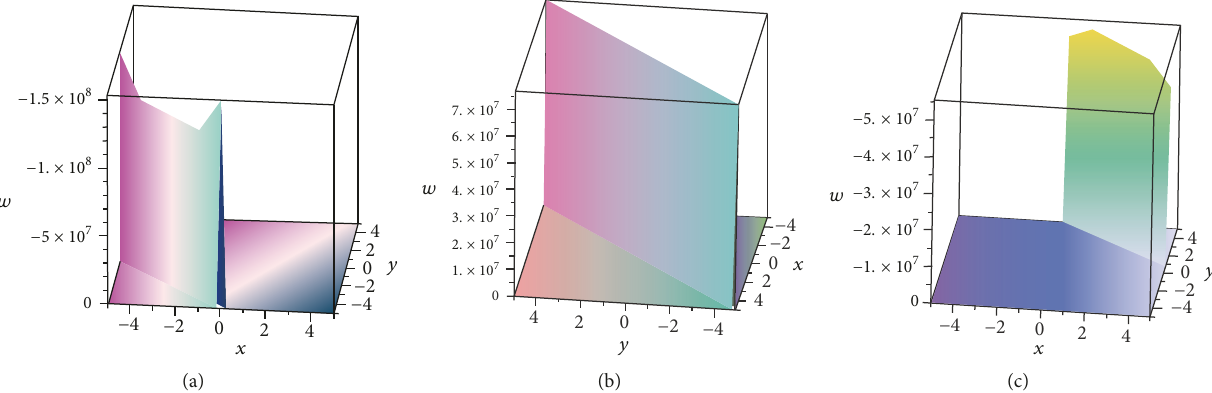
Figure 1: The solution of the (2 + 1)-dimensional Jaulent-Miodek equation corresponding to 𝑤 𝑟,2 (𝑧) , (a) 𝑡 = −5 , (b) 𝑡 = 0 , and (c) 𝑡 = 5 .